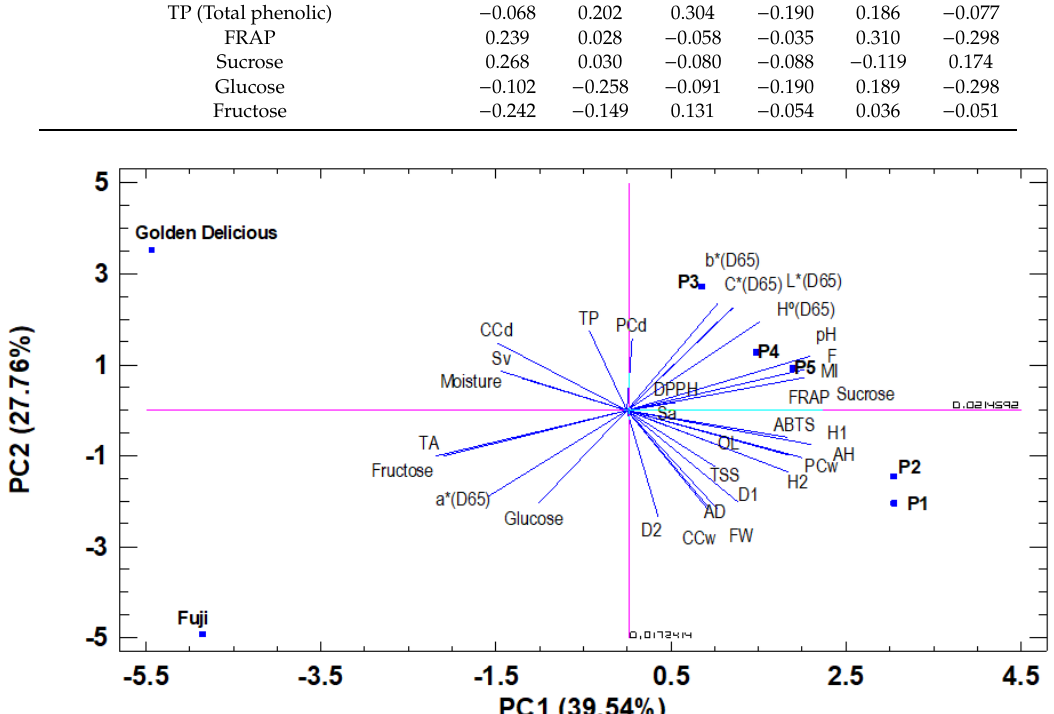
Figure 3. PCA of the measured parameters. Biplot PC1-PC2.